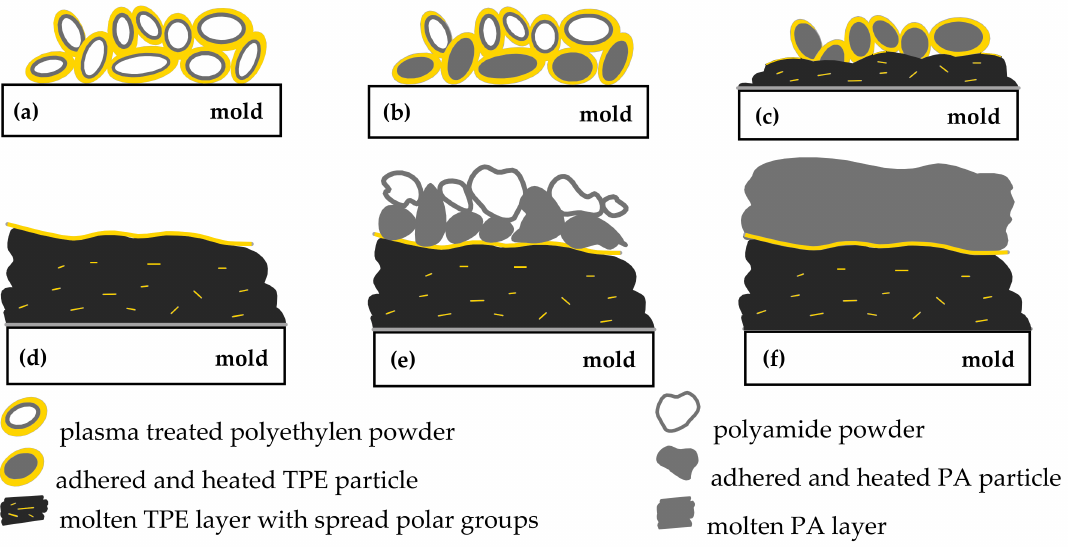
Figure 7. The TPE and PA layer built-up in multilayer rotational